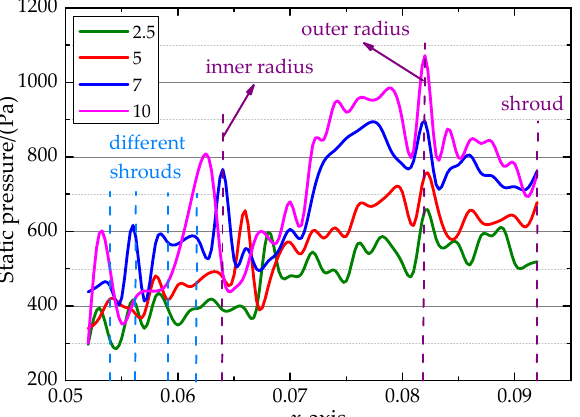
Figure 17. Change rules of static pressure along the x -axis under the di ff erent values of the distance c 3